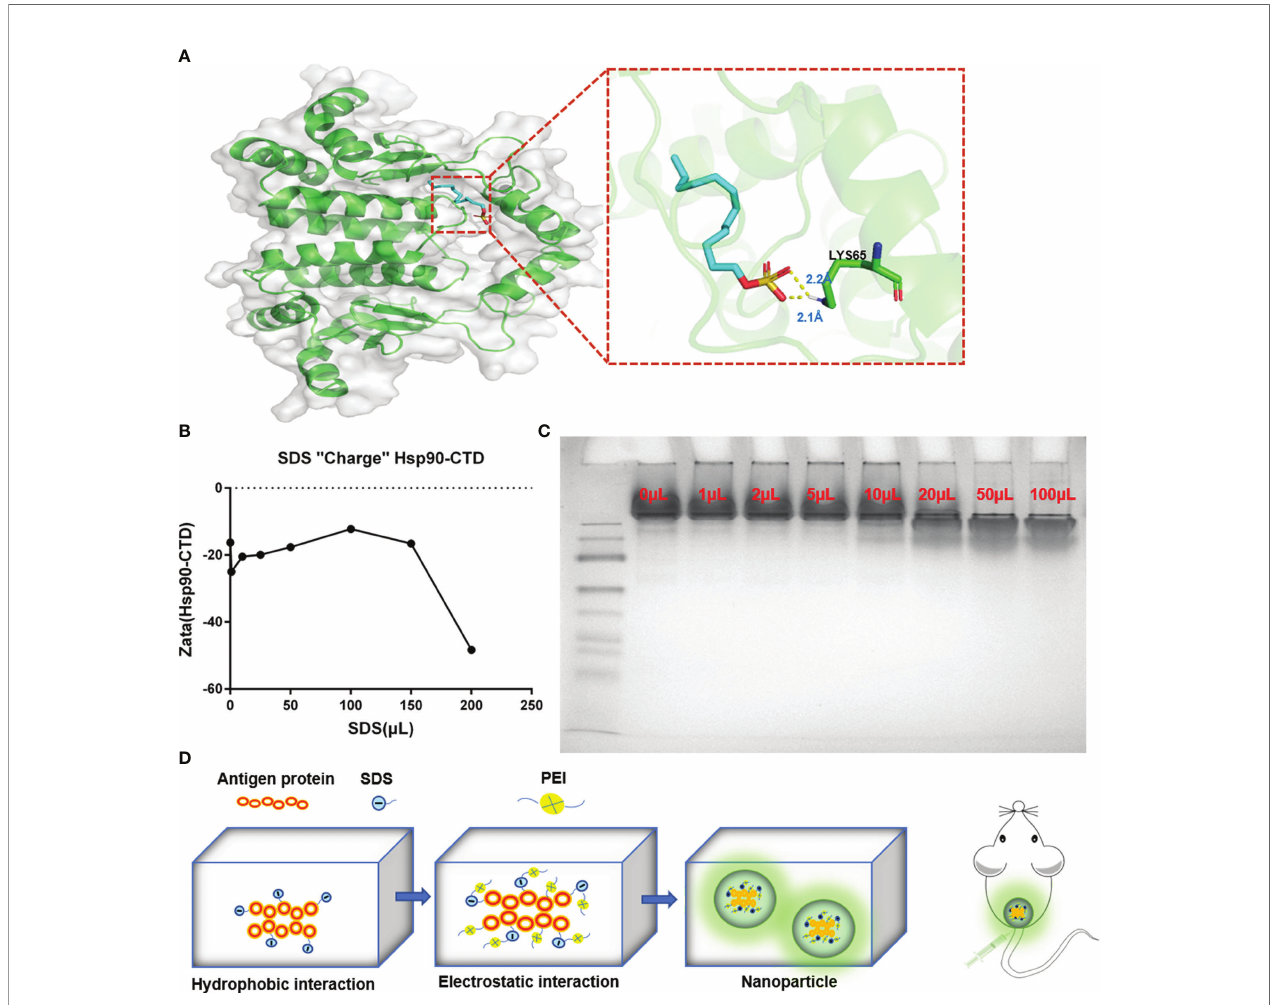
FIGURE 3 | Formation mechanism of Hsp90-CTD nanovaccine. (A) The putative binding site of SDS on protein Hsp90-CTD as obtained from Autodock, shows the hydrophobic interaction between SDS and Hsp90-CTD. Molecule SDS forms 2 hydrogen bonds with amino acid LYS65, acting at distances of 2.3 Å and 2.1 Å (B) DLS detects the solution potential value. Changes in potential of Hsp90-CTD protein combined with different volumes of SDS solution. (C) Native-PAGE: The migration ef fi ciency of protein Hsp90-CTD combined with different volumes of SDS solution was analyzed on 10% Native-PAGE. (D) Schematic illustration of the process for synthesizing nanoparticles. Hsp90-CTD and SDS were combined with hydrophobic force. Then the polymer PEI was introduced to combine with the mixture by electrostatic force. Finally, well-characterized nanoparticles were